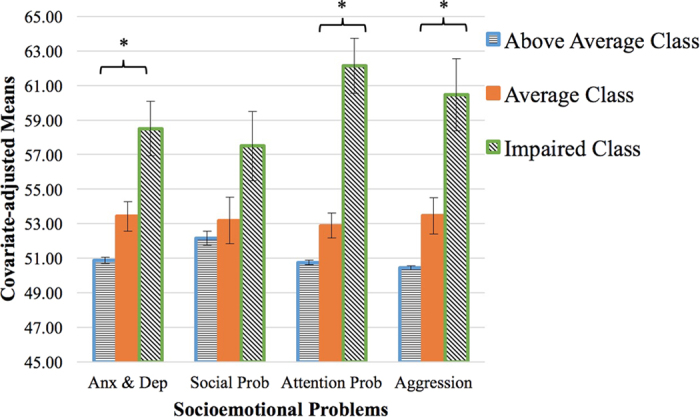
Differences in socioemotional problems between EF classes.Each class differed from each other on symptoms of anxiety/depression, attention problems, and aggression as measured by the Child Behavior Checklist after controlling for diagnosis. *Indicates a significant difference between all classes indicated by non-overlapping confidence intervals.